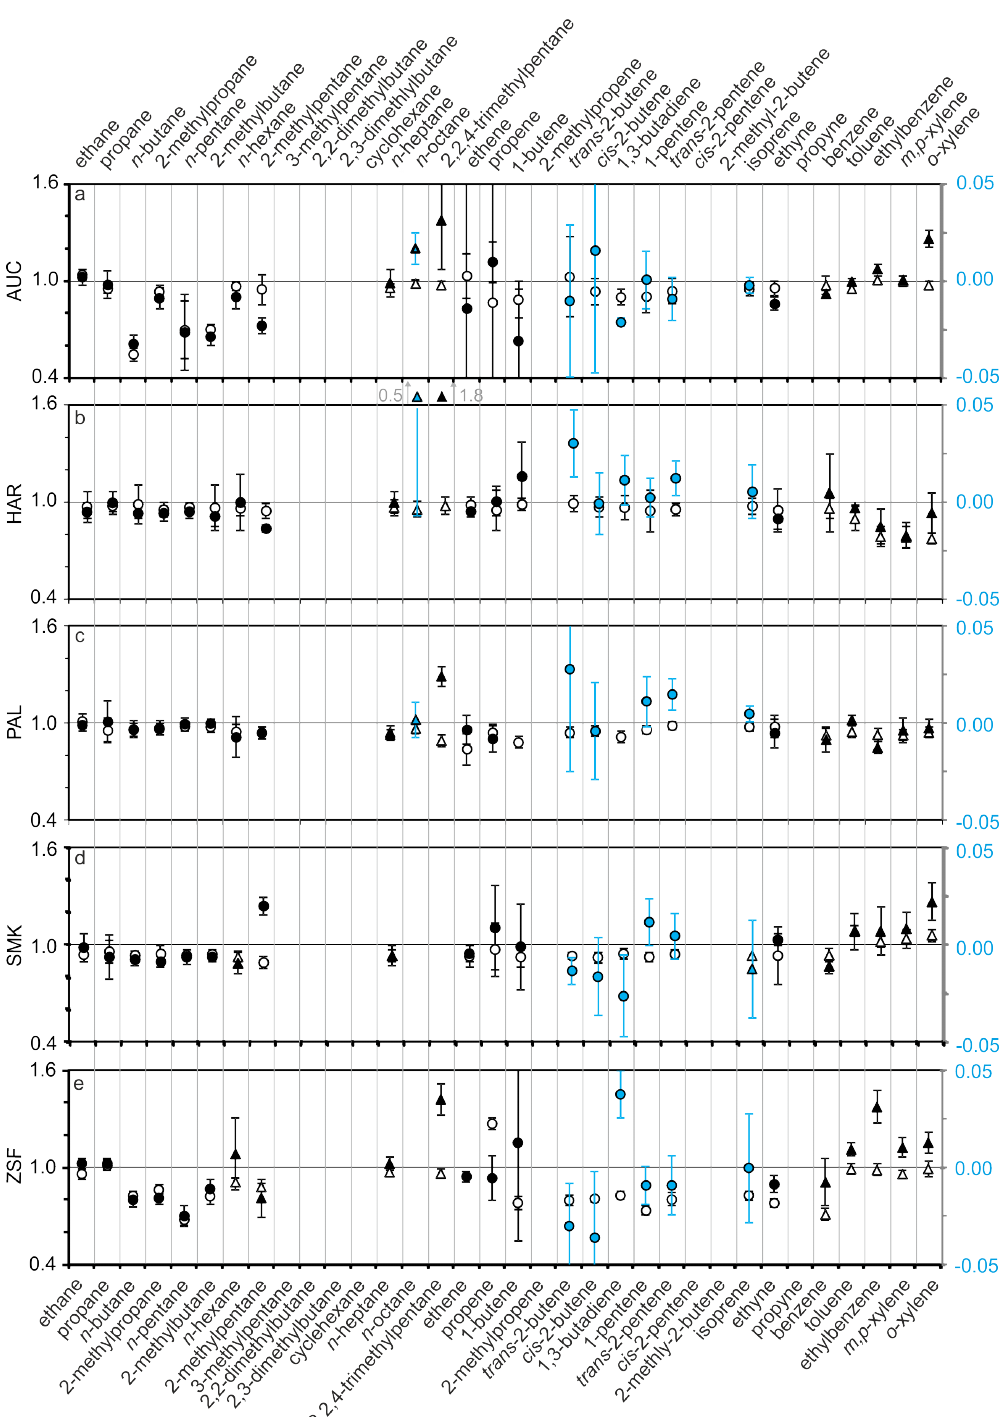
Figure 2. Mole fractions for NMHC_N 2 and NMHC_air normalised to the assigned values. Circles (O) indicate separation column one, triangles ( (cid:49) ) separation column two. Open symbols indicate NMHC_N 2 , filled symbols NMHC_air. Black symbols indicate results for mixing ratios >0.1nmolmol − 1 (left axis, ratios to assigned values), blue symbols for <0.1nmolmol − 1 (right axis, difference to assigned values, see text). Error bars show the expanded combined